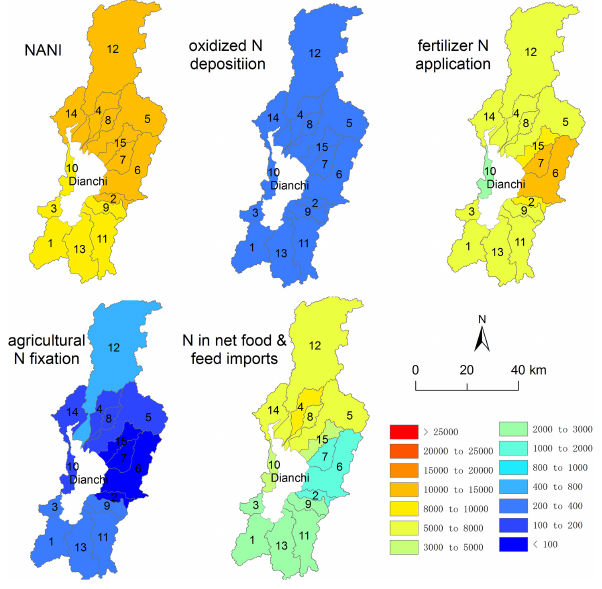
Figure 3. NANI (kgNkm − 2 yr − 1 ) and its components for the Lake Dianchi basin based on the land use-weighting method. A high value of NANI and its components could be observed in this method, especially for catchments 4, 14, and